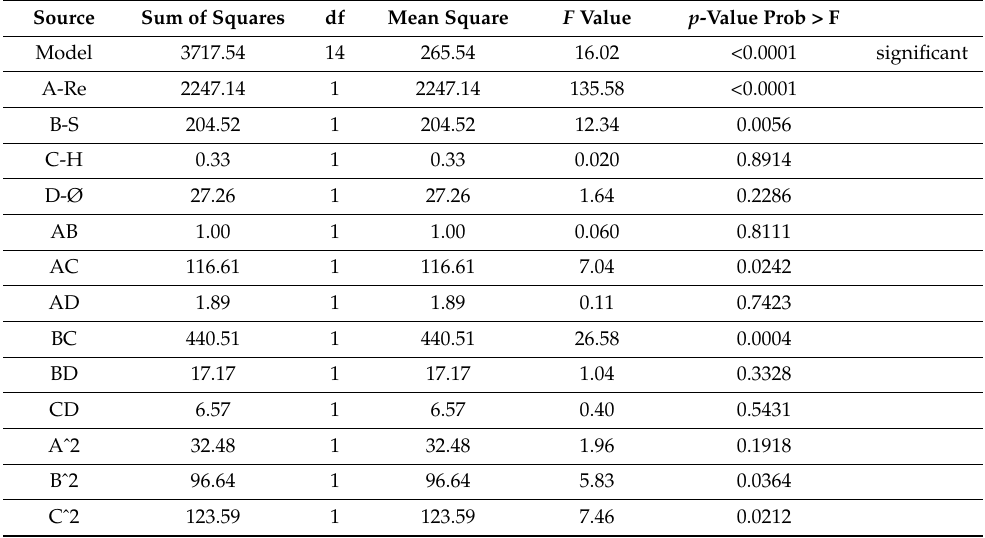
Table 3. ANOVA for Response Surface Quadratic Model (Analysis of variance